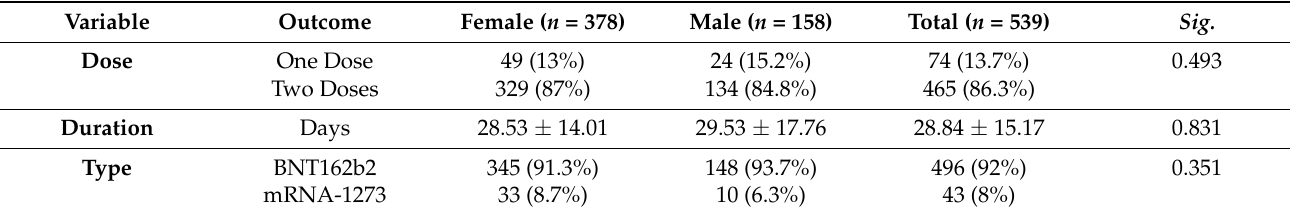
Table 2. mRNA-based COVID-19 vaccine-related anamnesis of young adults (18–30 years old), Czech Republic, April–June 2021 ( n =